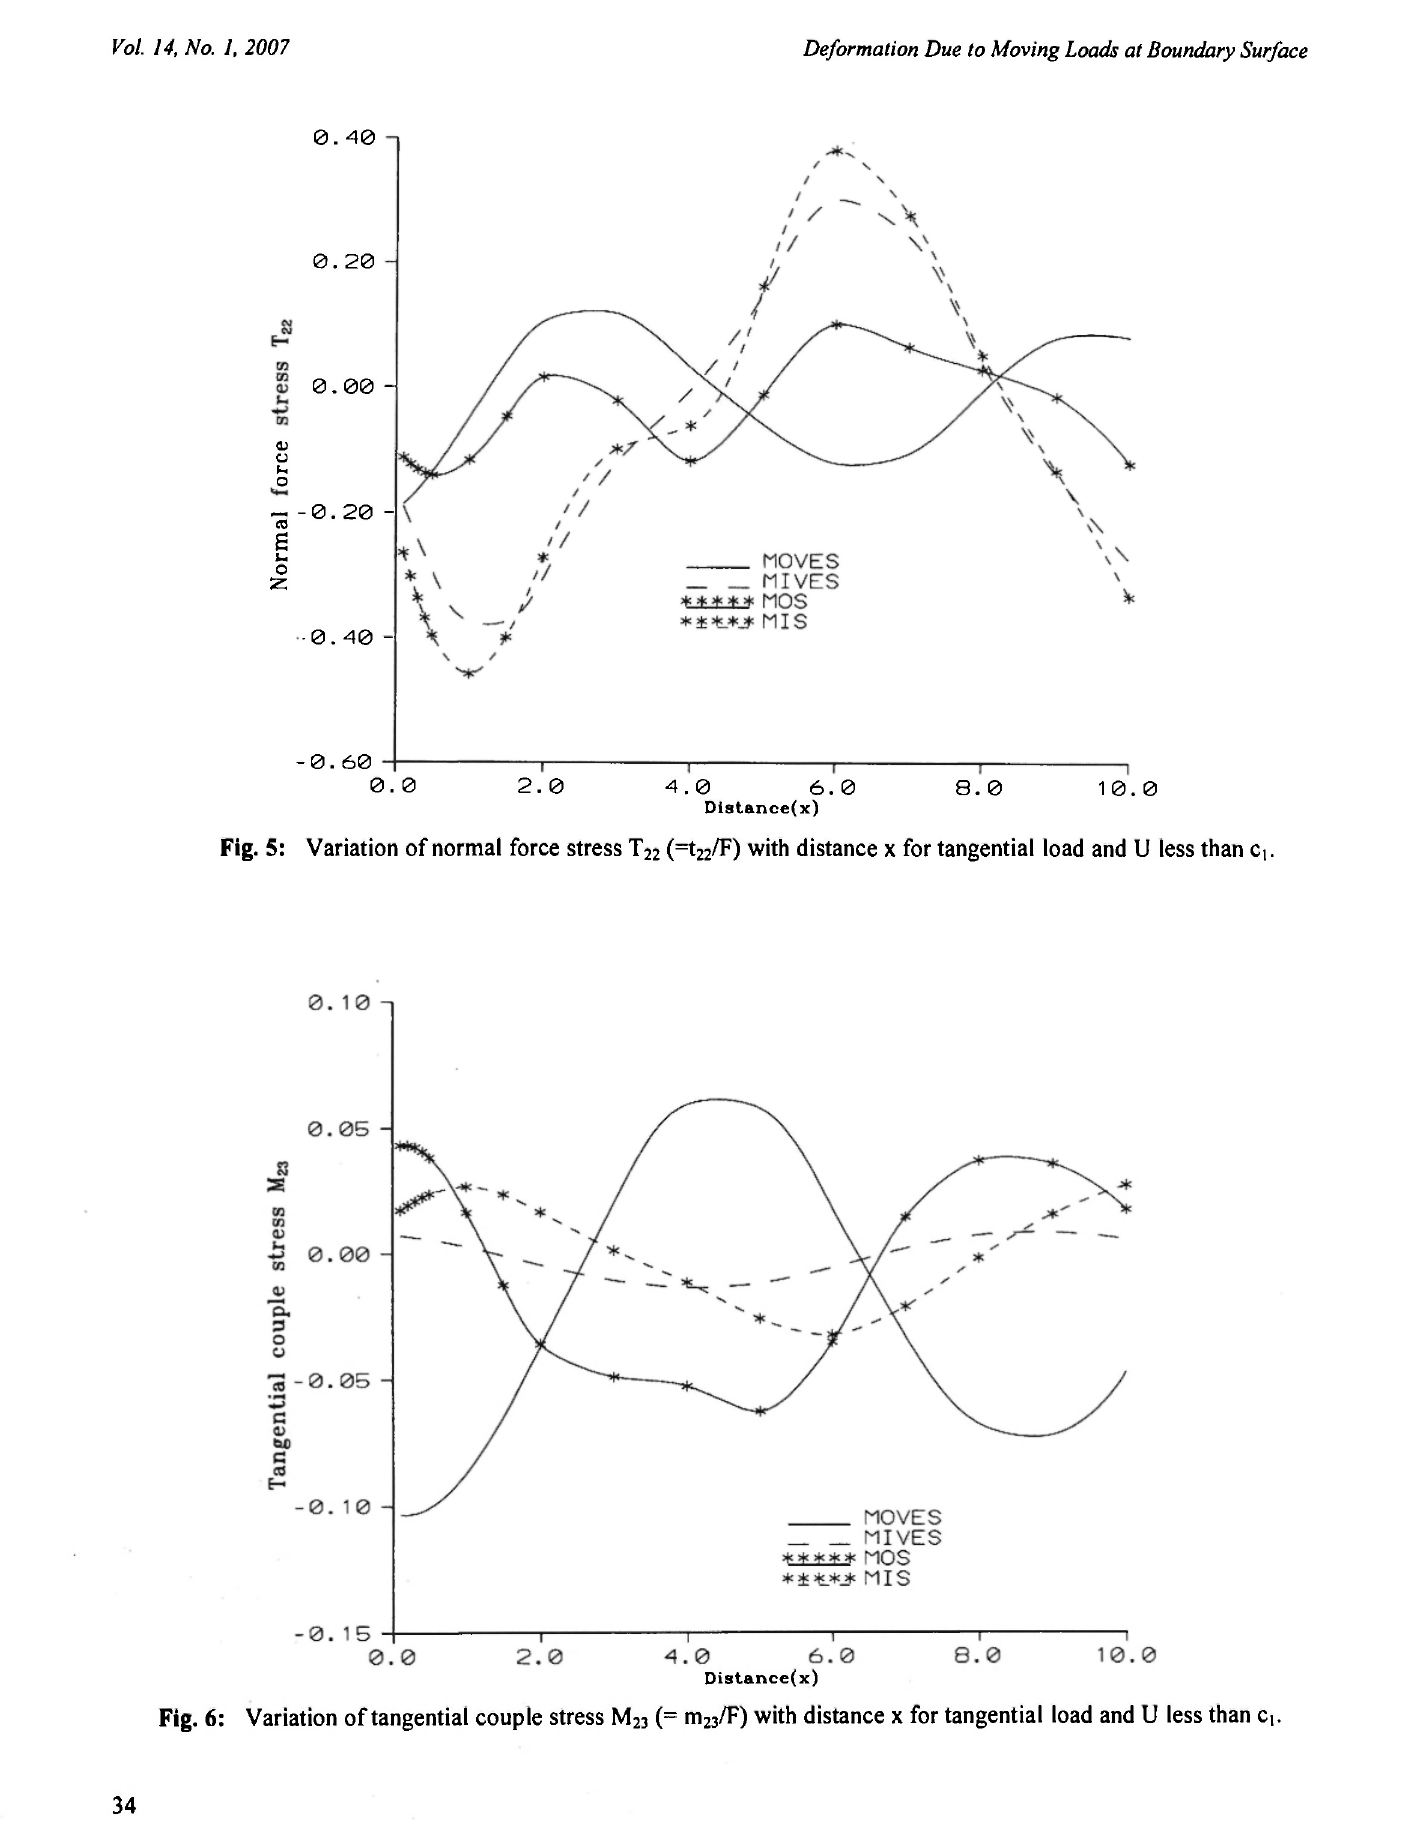
Fig. 6: Variation of tangential couple stress M 2 3 (= 1TI23/F) with distance χ for tangential load and U less than c t .